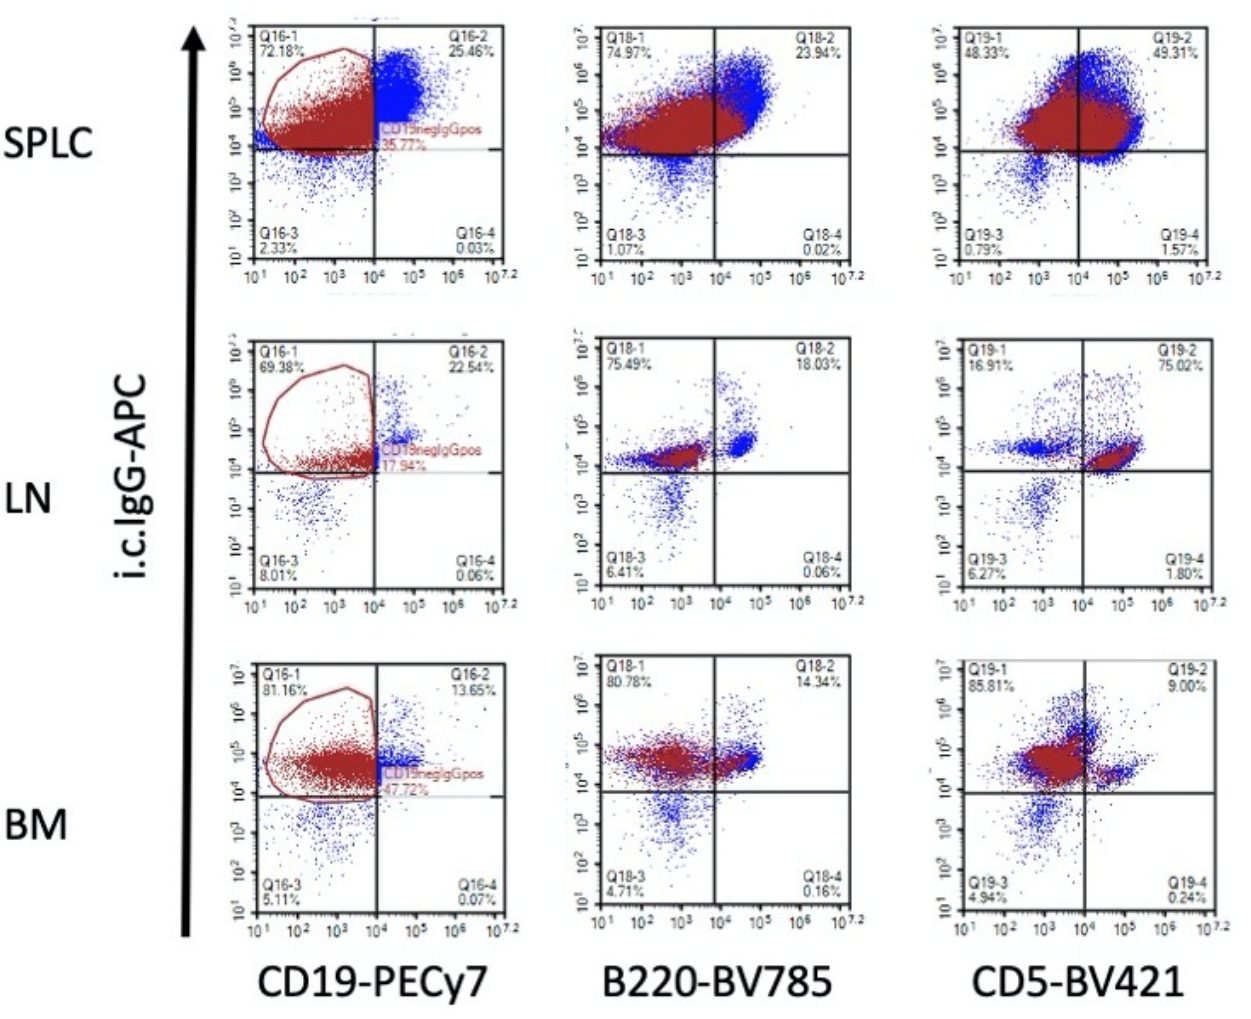
Figure 4. Overlap between CD19-i.c. IgG+, B220-i.c. IgG+ and CD5-i.c. IgG+ populations. Using one of the SAL/CO samples, CD19-i.c. IgG+ cells were identified in the dot plot as red so that overlapping populations could be detected across gates and tissues. Data from one of the SAL/CO samples of one of the two experiments are representative.